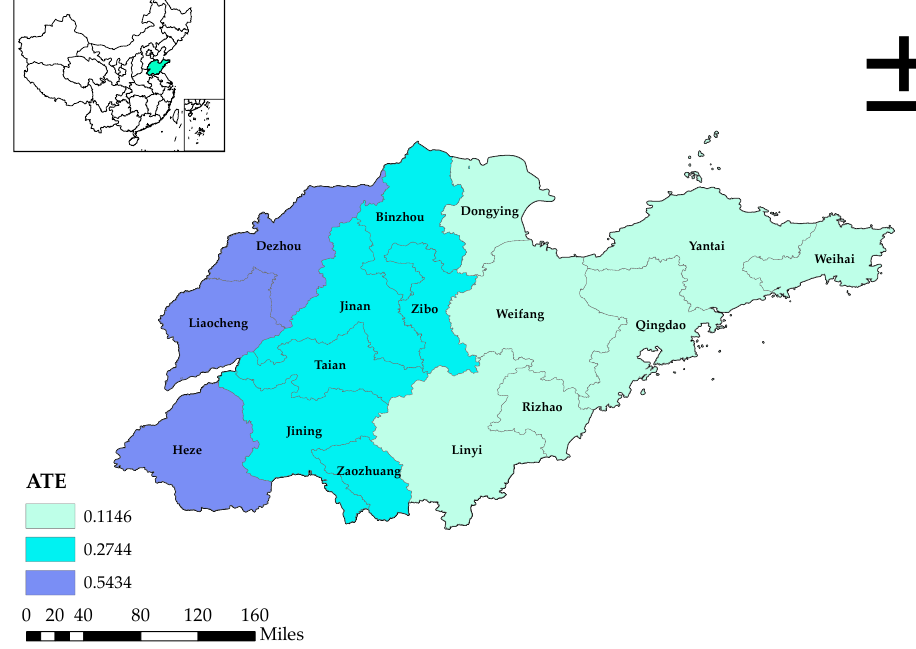
Figure 3. The ATEs of Three Regions.